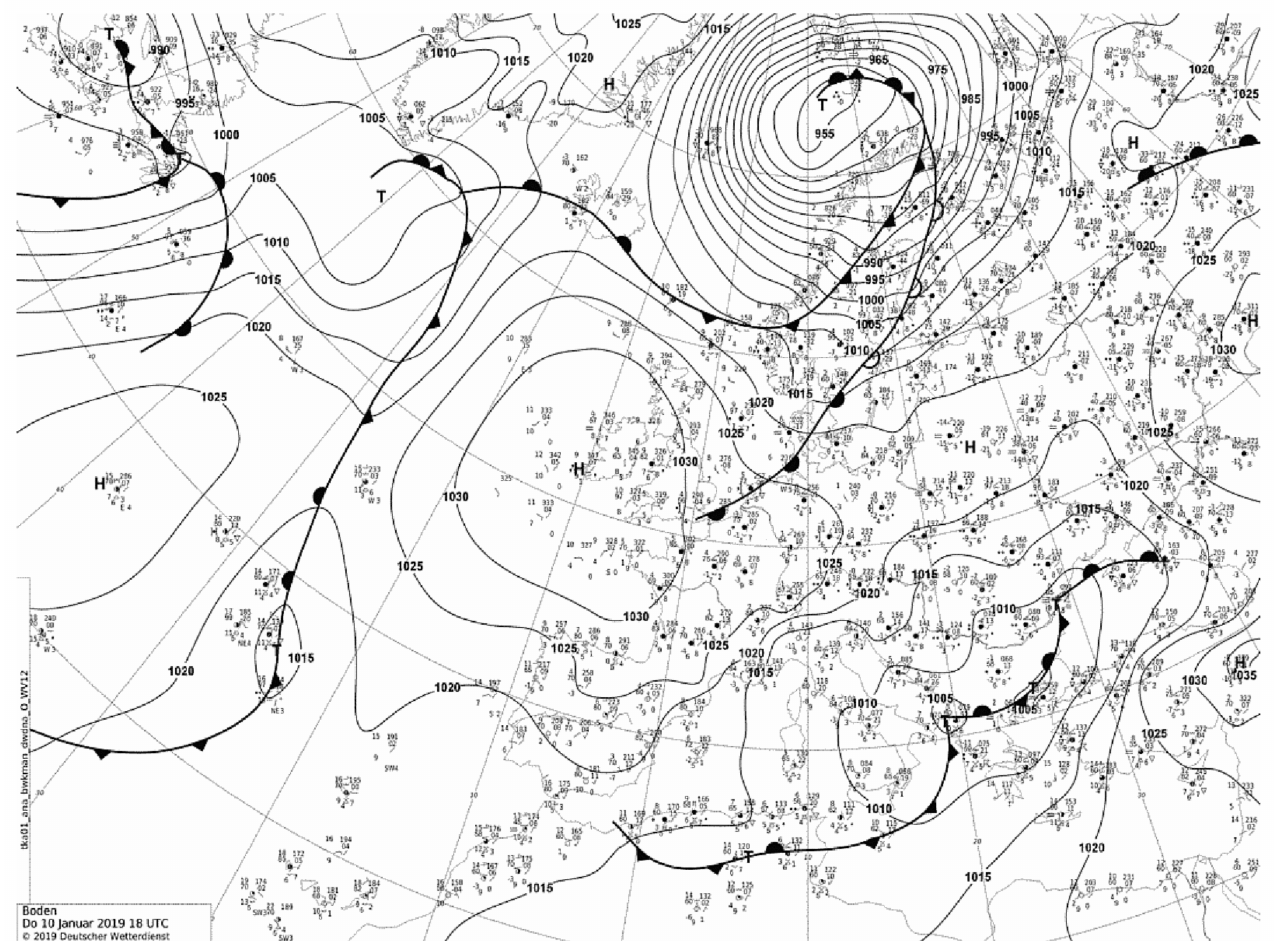
Figure 7. Weather map valid 18 UTC 10 January